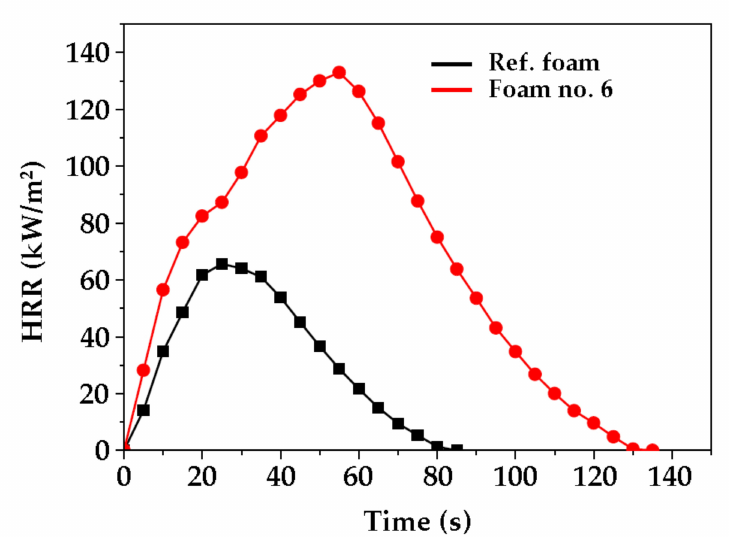
Figure 7. Comparison of the heat release rate (HRR) of the reference foam (Ref.) and foam based on MSA- and PLA-polyol (no. 6) as function of